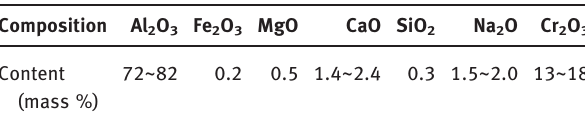
Table 1: Chemical composition ranges of different batches of chro- mium slag.